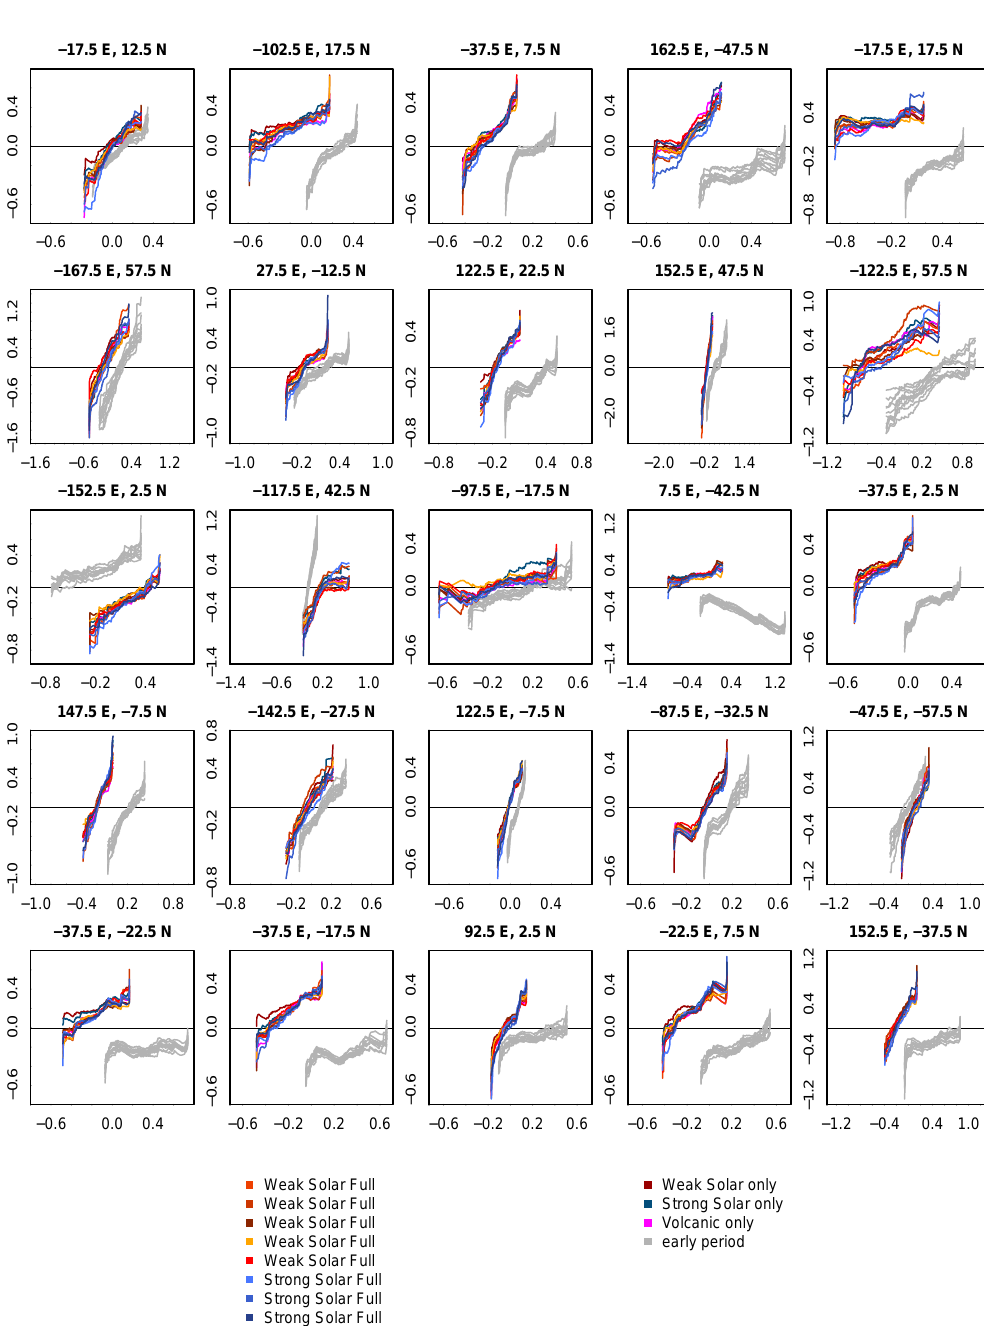
the sub-periods of 250 records. For example, SIM is con- sistent with the target in the North Atlantic sub-polar gyre region for the early sub-period (about 800 to 1050, Fig. 10b) but not for the following one (Fig. 10c). Overall,